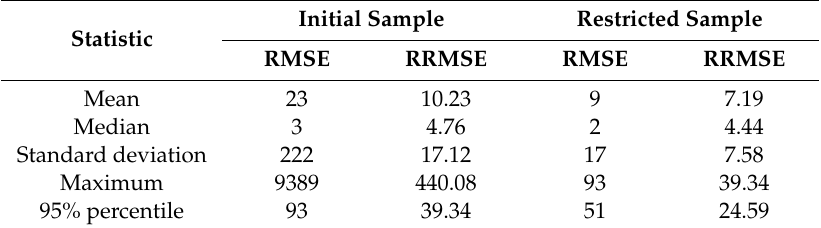
Table 2. Fitting the credit default swap (CDS) term structure. The table reports the calibration results on monthly term structures of CDS spreads. The root mean squared errors (RMSE) and the relative root mean squared errors (RRMSE) are expressed in basis points and in percentage points, respectively. The initial sample contains 52,021 firm-month observations. The restricted sample is obtained by excluding the 5% of observations with the worst